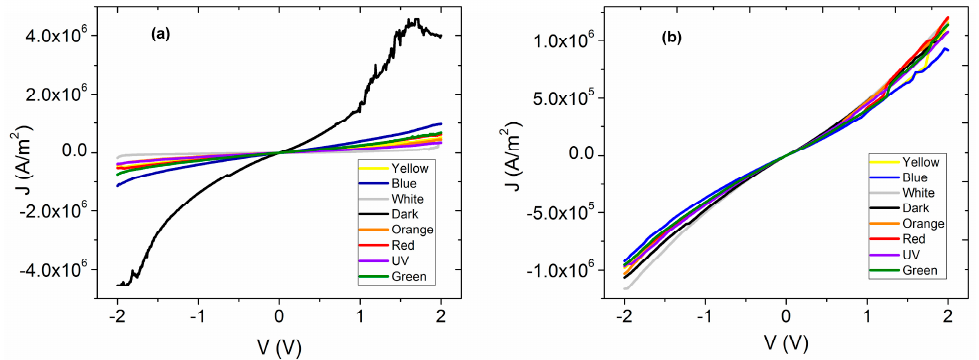
Figure 6. J - V characteristics of ( a ) membrane and ( b ) semiconductor film irradiated 8 h.